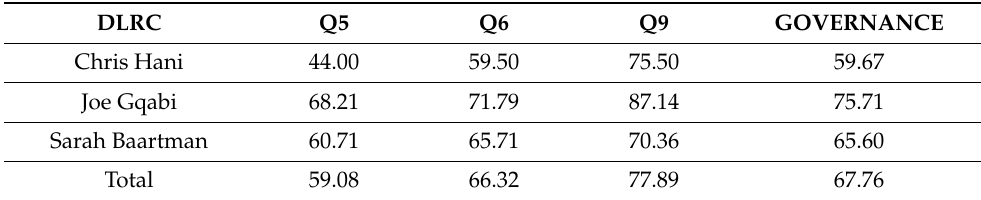
Table 6. Governance (average standardized assessment score in